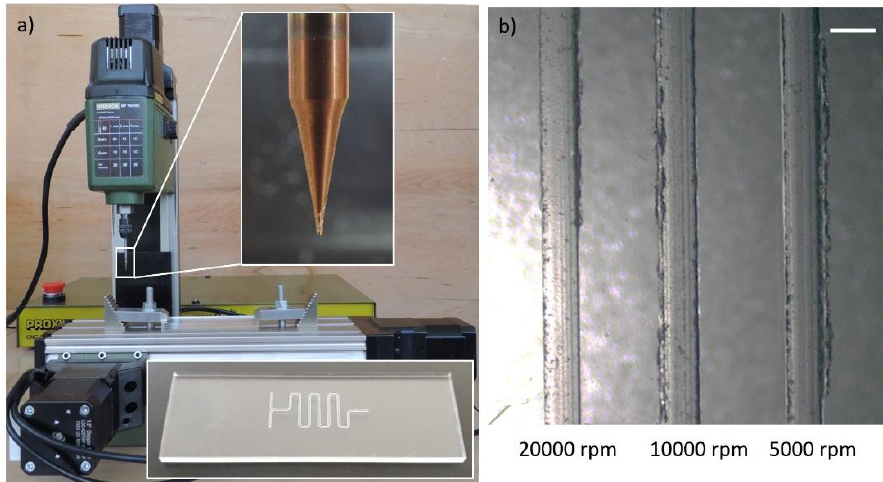
Figure 4. Proxxon MF70/CNC-Ready micro milling machine at Middle East Technical University, Mechanical Engineering Department and close-up views of 400 µm diameter end-mill and a sample microfluidic device (serpentine micromixer) milled on PMMA substrate. ( b ) Microscope view of channels micromilled at 20,000 rpm, 10,000 rpm and 5000 rpm spindle speeds after 2 min sonication. Feed rate was fixed at 3 mm/min. Increasing burr formation with decreasing spindle speed implies overheating problems at low-feed (less than 10 mm/min) milling at low spindle speeds. Scale bar shows 500 µm.